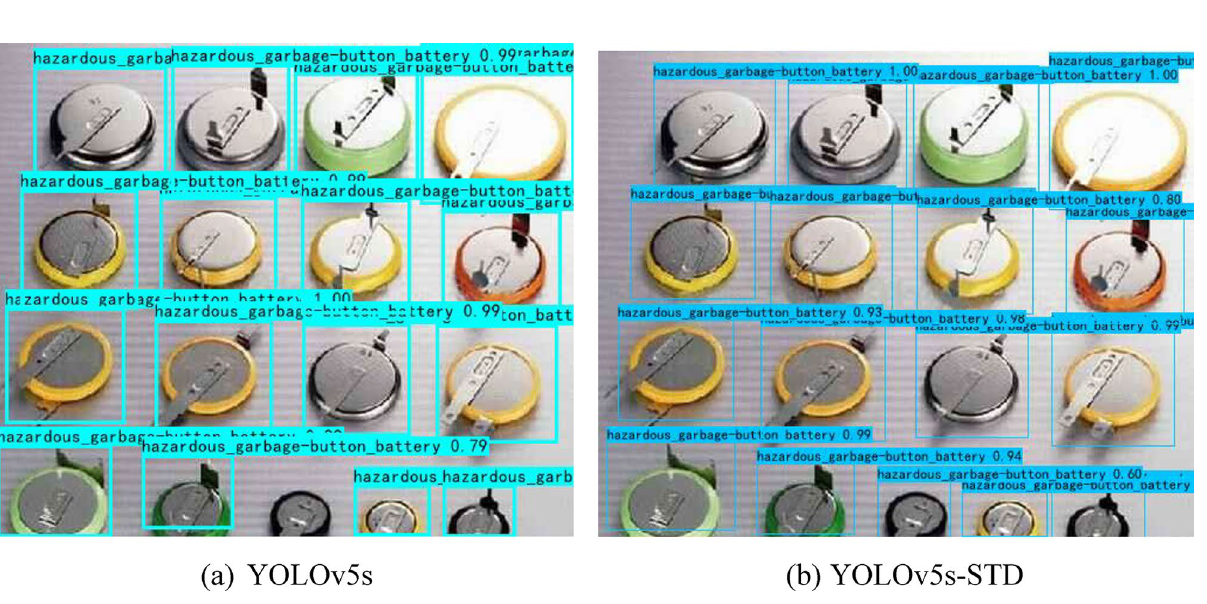
As shown in Table 9, the mAP@0.5 of the YOLOv5s-STD network model reaches 93.6%, a 1.8% improvement of mAP@0.5 compared to the original YOLOv5s network model. From Fig. 10, there are no missed detection behaviors when using the YOLOv5s-STD network model, and all the target objects are detected. However, the original YOLOv5s network model has missed target object behavior when detecting multiple and small targets. Increasing the small target detection layer not only improves the detection accuracy of the model but also solves the problem of the original model in detecting small and multiple targets.